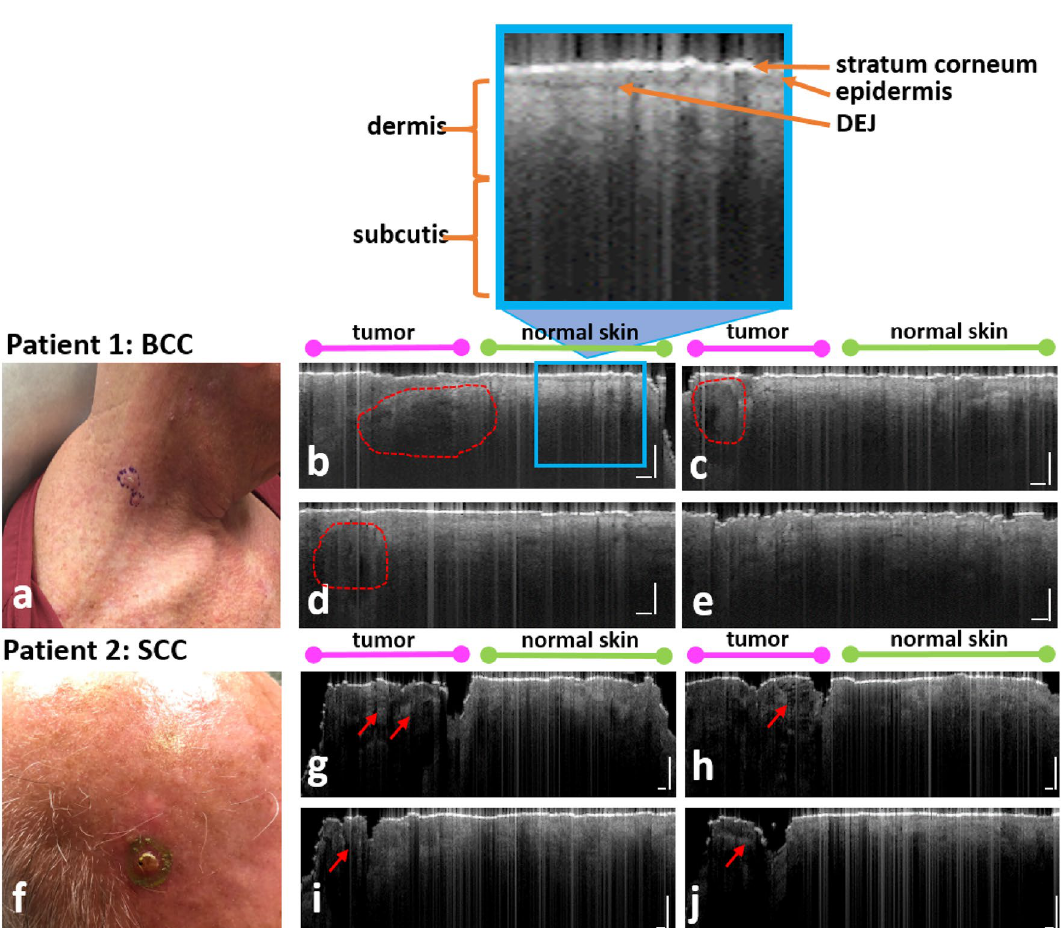
Figure 6. ( a ) Clinical photo of the BCC lesion on the right neck imaged in Patient 1, with ( b – e ) showing corresponding OCT images. ( f ) Clinical photo of the SCC lesion on the scalp imaged in Patient 2, with ( g – j ) showing corresponding OCT images. The left side of each scan ( b – e ), ( g – j ) represents the tumor, as can be seen by the disrupted epidermal architecture, with plug-like structures and upper dermis signal-free cavities in the BCC (areas enclosed by dashed red lines), and discrete bright regions below the surface in the SCC (red arrows). The right side of each scan represents adjacent normal skin, with more organized